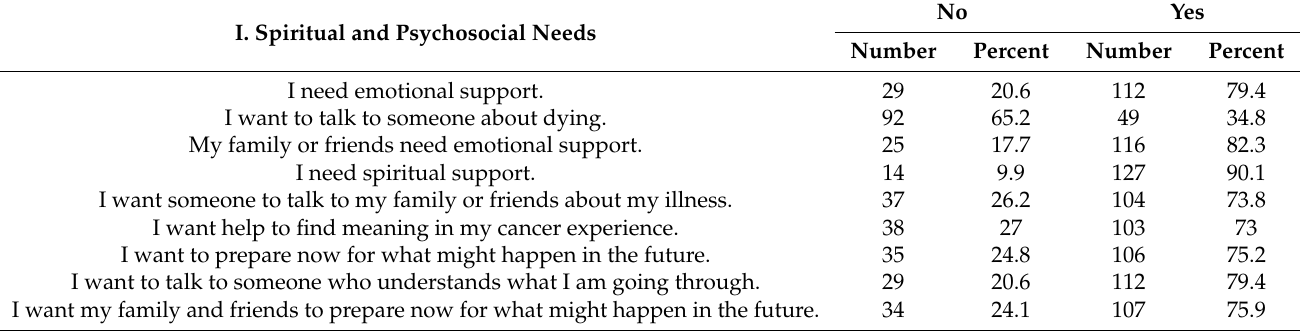
Table 3. Percentage of spiritual and psychosocial needs and practical need among the